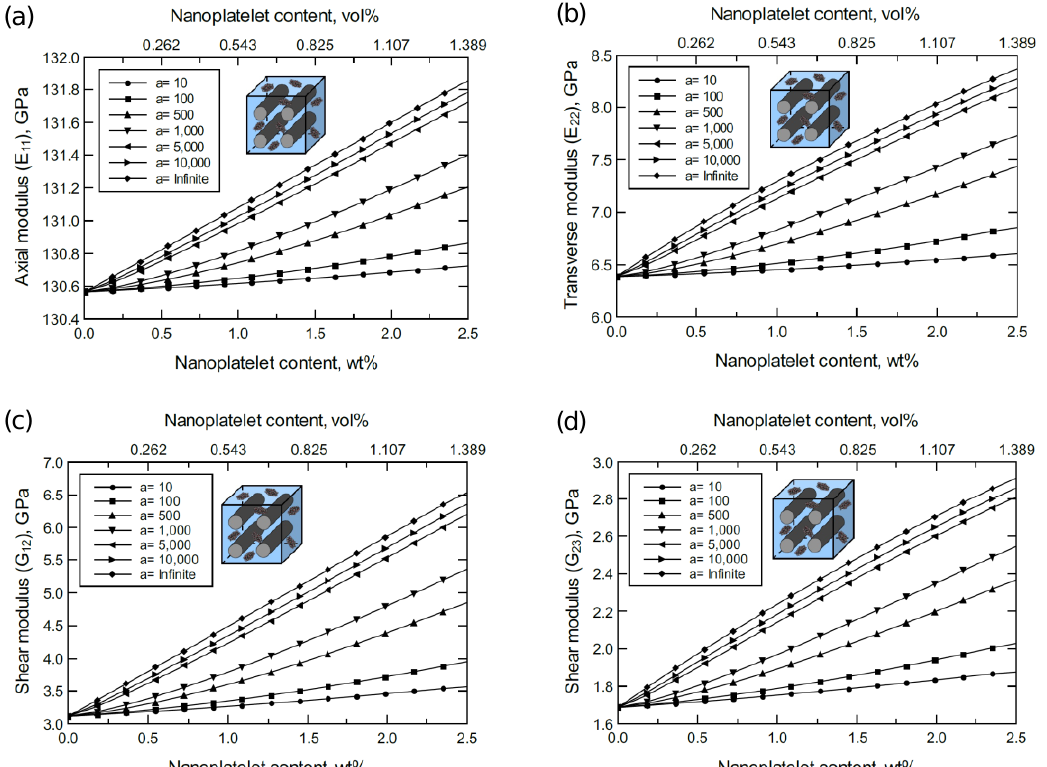
Figure 3. Predicted elastic and shear moduli for unidirectional CF/GNP/epoxy for various nanoplatelet content and aspect ratio values; ( a ) axial elastic modulus 𝐸 11 , ( b ) transverse elastic modulus 𝐸 22 , ( c ) shear modulus 𝐺 12 , ( d ) shear modulus 𝐺 23 . The volume fraction of CF is 56%.